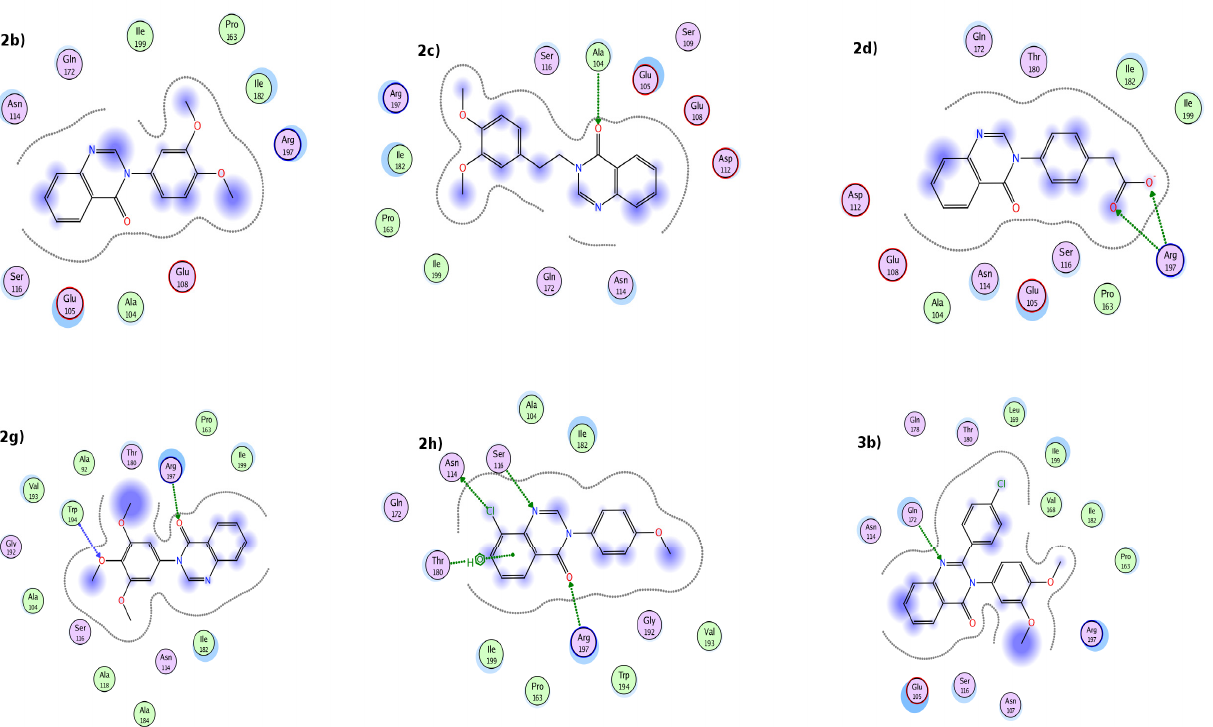
Figure 1. Docked ligand at the receptor binding site. This picture represent 2D-interactions for the newly synthesized inhibitors within the binding pocket of target receptor using Poseview.